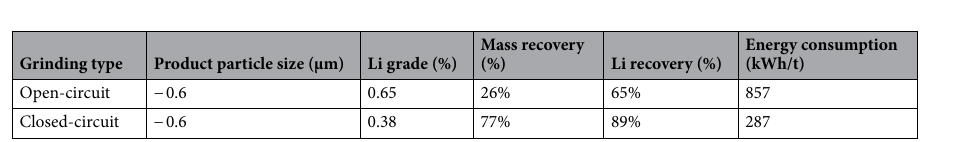
Table 3. Comparison of the closed-circuit grinding versus the open-circuit grinding.